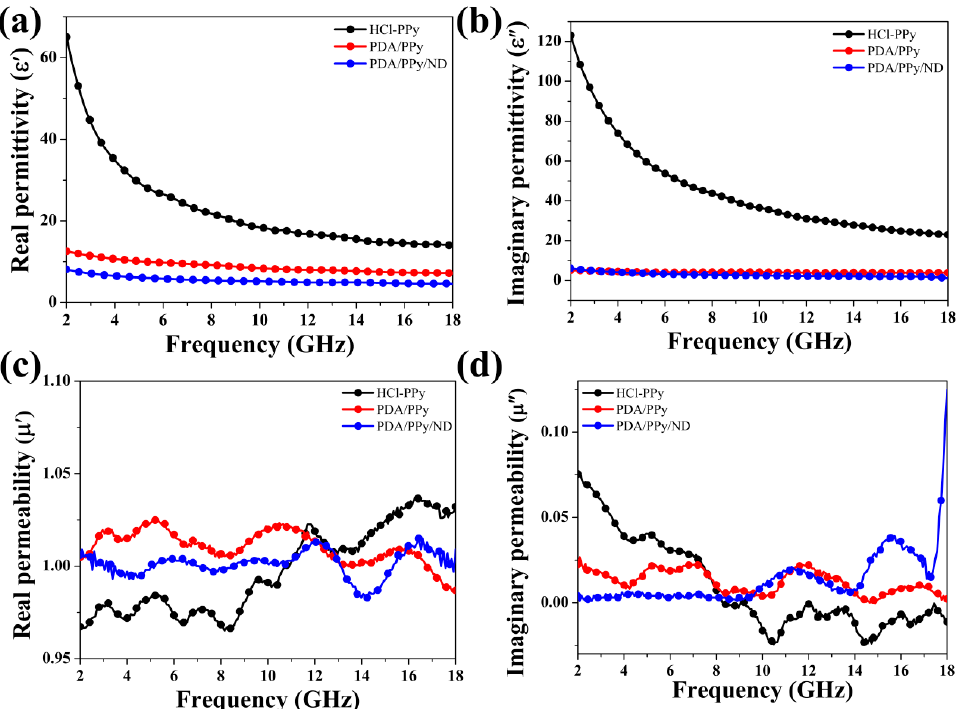
Figure 4. The measured EM parameters of the samples: ( a ) real permittivity, ( b ) imaginary permittivity, ( c ) real permeability and ( d ) imaginary permeability .